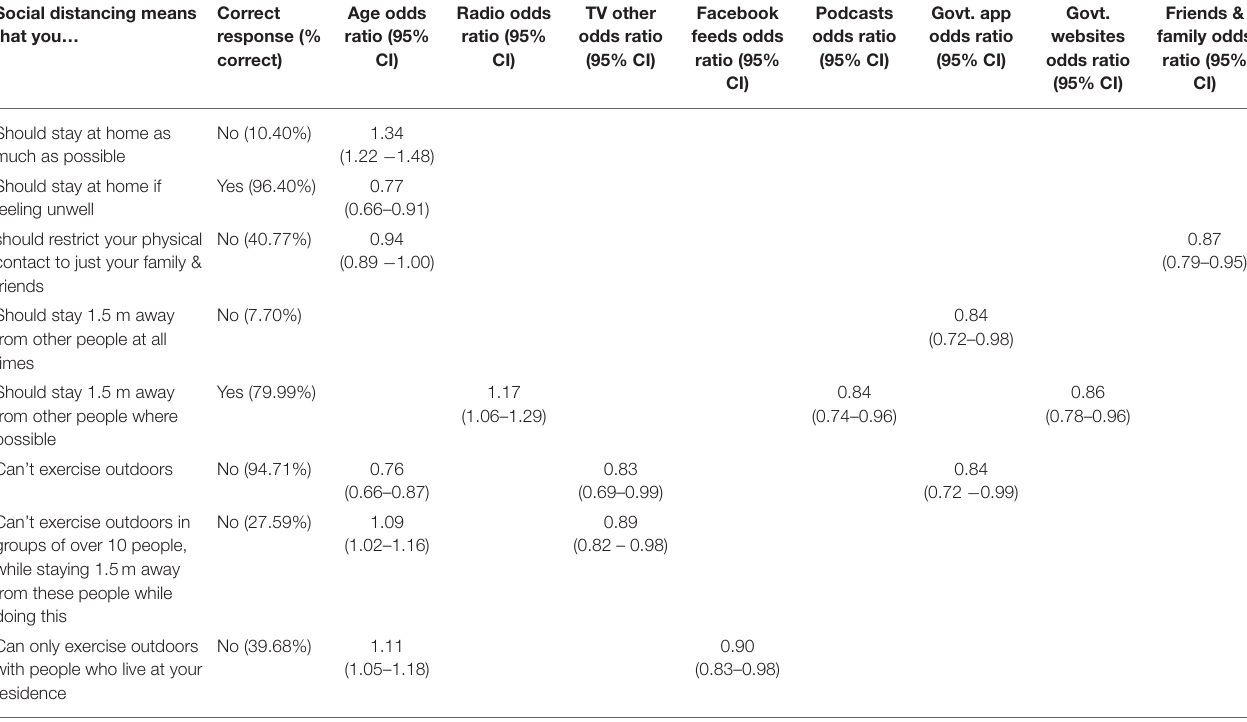
TABLE 3 | Factors (age and information sources) associated with correct responses to the questions regarding social distancing. Social distancing means that